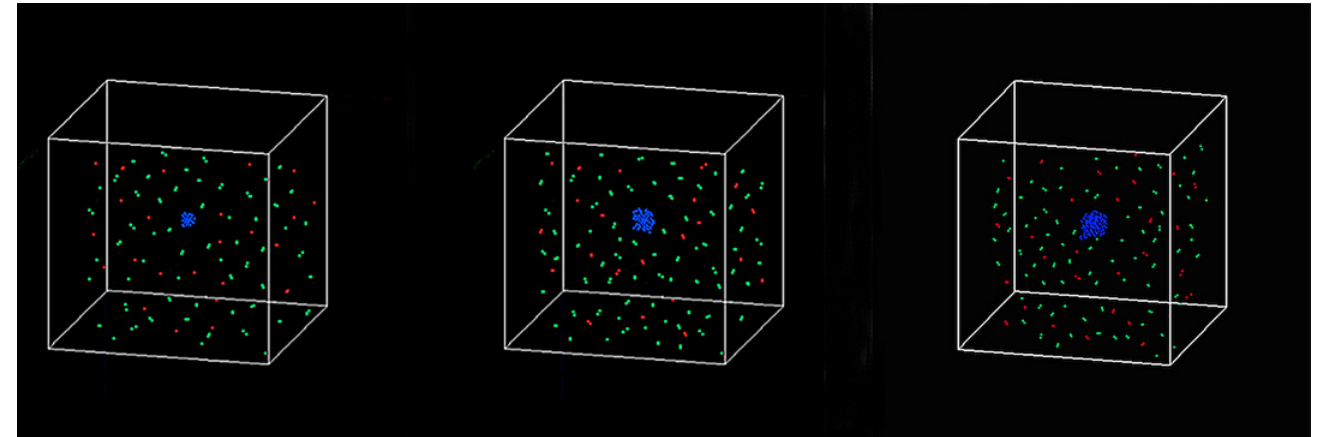
Fig 10. 3D snapshots of the tumor system with single-agent GC treatment at (a) time step 60, (b) time step 65 and (c) time step